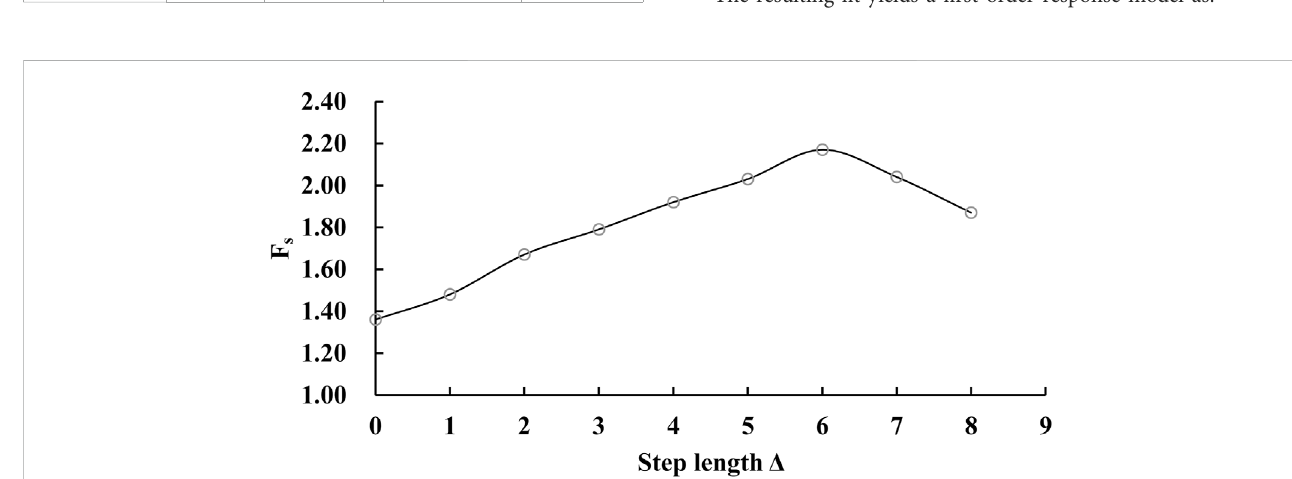
FIGURE 7 The variation pattern of the tunnel stability reserve factor with step length along the steepest ascent